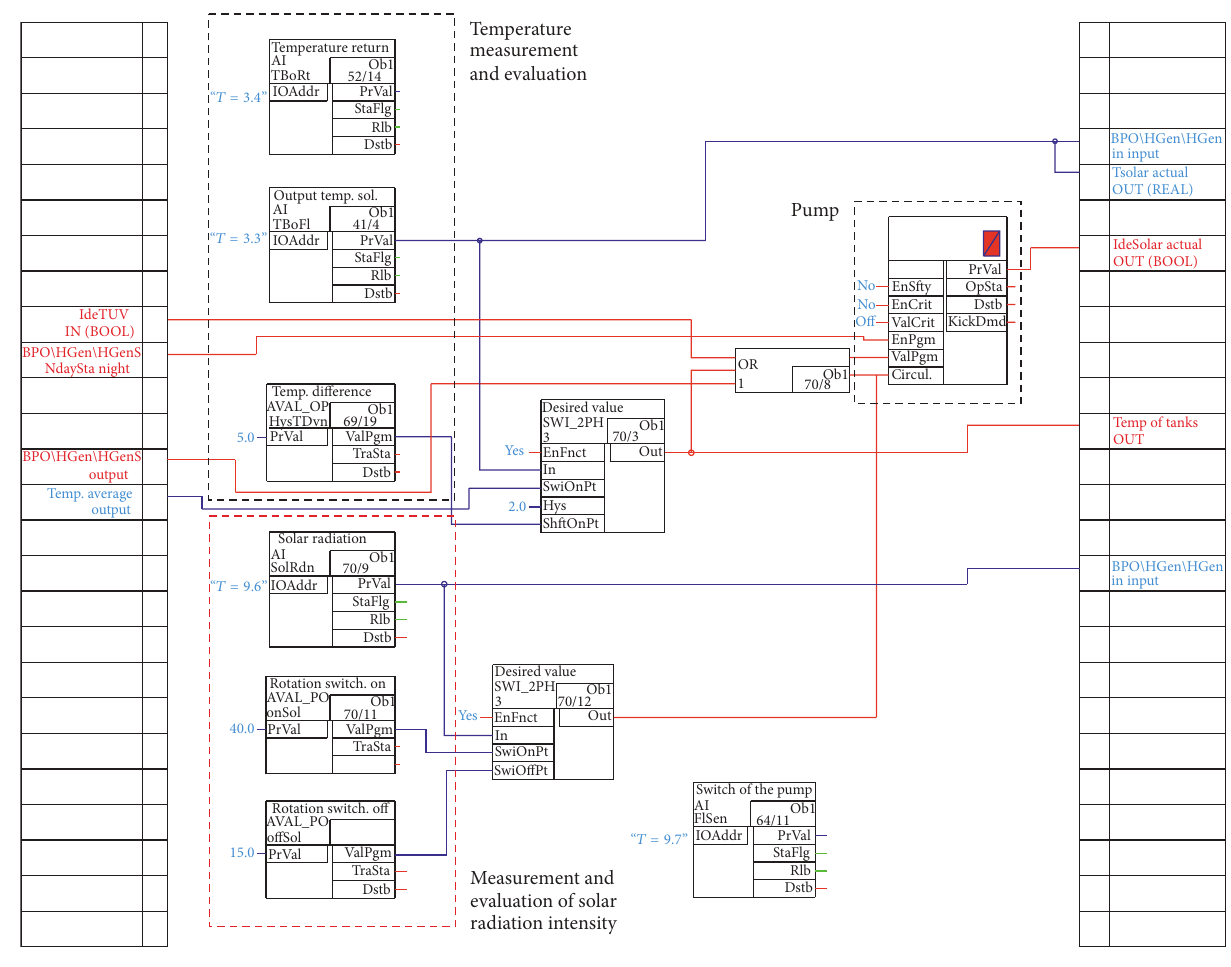
Figure 8: A diagram of the pump system control.